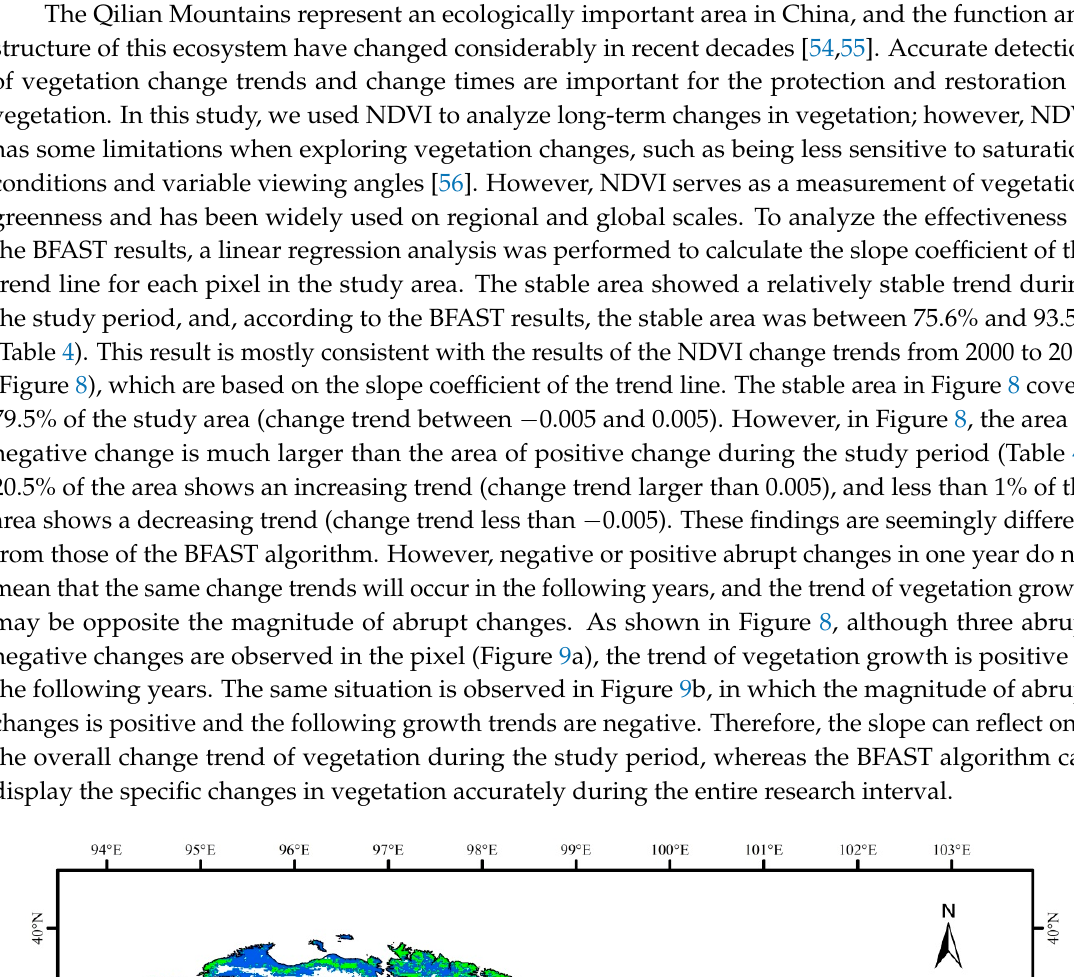
Figure 7. Area percentages of negative and positive trend changes for each year of the study period (2000–2017). Negative and positive values indicate abrupt vegetation browning and abrupt vegetation greening, respectively.